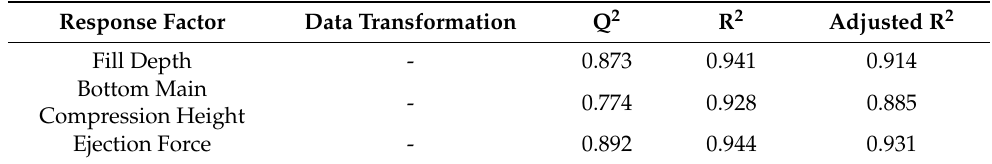
Table 8. Overview of fit statistics regarding tablet-press parameters. Response